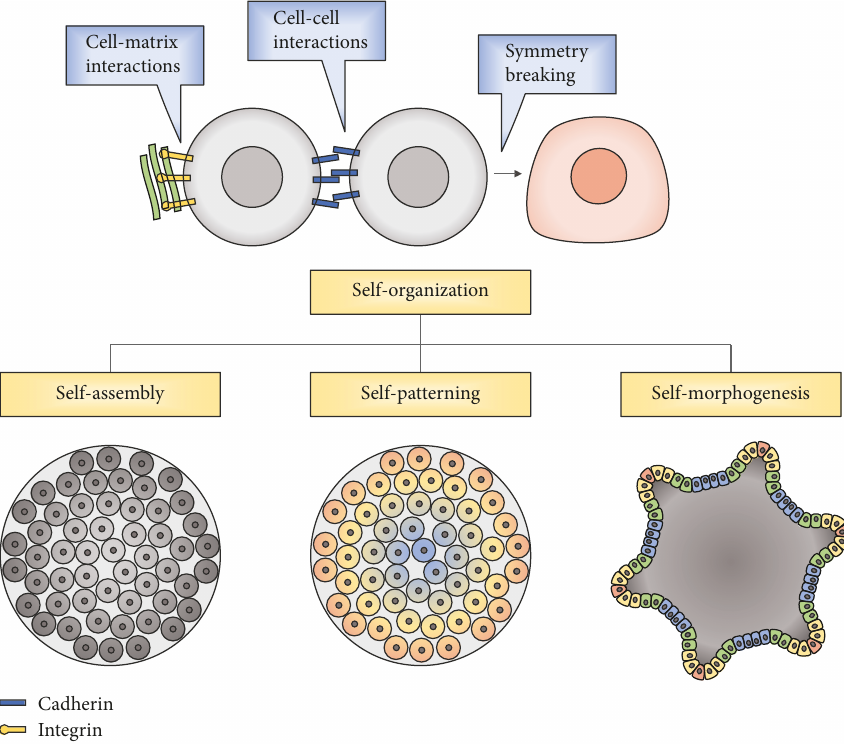
Figure 1: In tissue morphogenesis, the self-organization capacity of cells is achieved by a multicellular process involving cell-cell and cell- matrix interactions, as well as symmetry breaking. This capacity includes a combination of self-assembly, self-patterning, and self- morphogenesis capacities, which involves the control of the cell position, spatiotemporal control of cell stage, and control of tissue